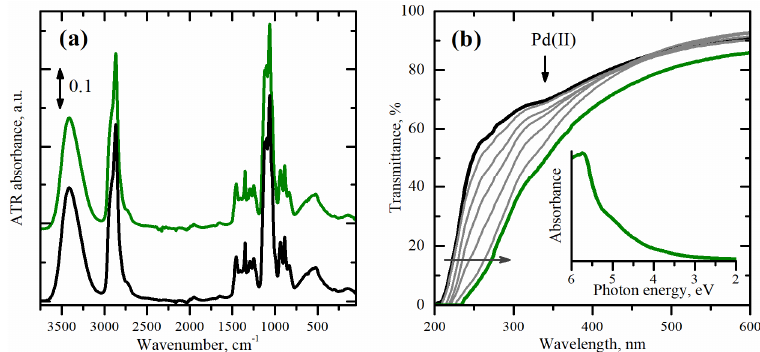
Figure 5. ( a ) Fourier transform infrared (FTIR) and ( b ) UV-Vis spectra of the mixture of reagents for Pd-NPs PEG collected at the beginning (black) and at the end (green) of the synthesis. Intermediates are shown in grey. ATR: attenuated total reflectance.